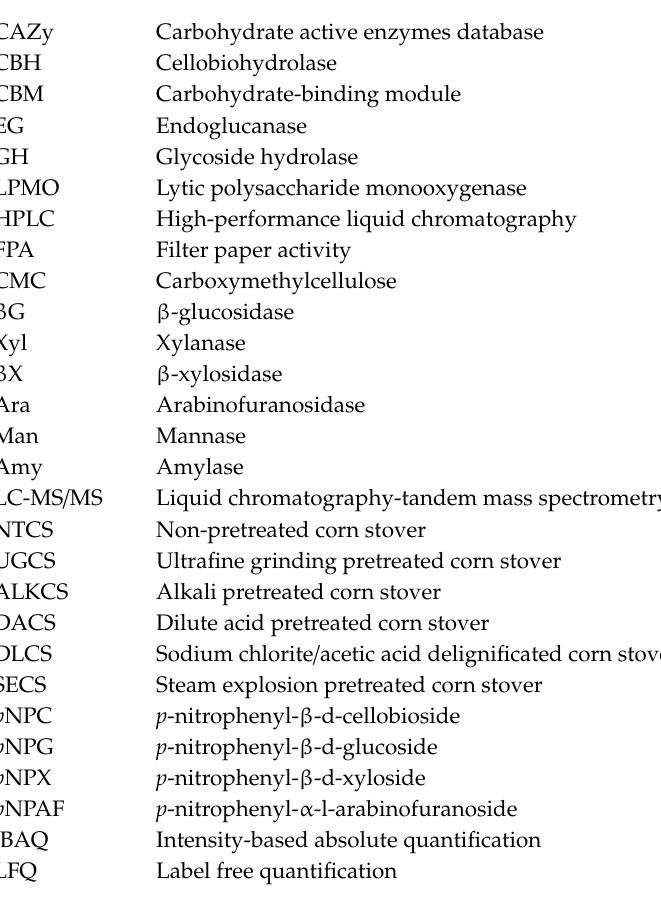
Table S1: A comparison of di ff erent previous reported enzyme cocktails for lignocellulose saccharification. Figure S1: Distribution of glycoside hydrolase family in proteome of T. harzianum